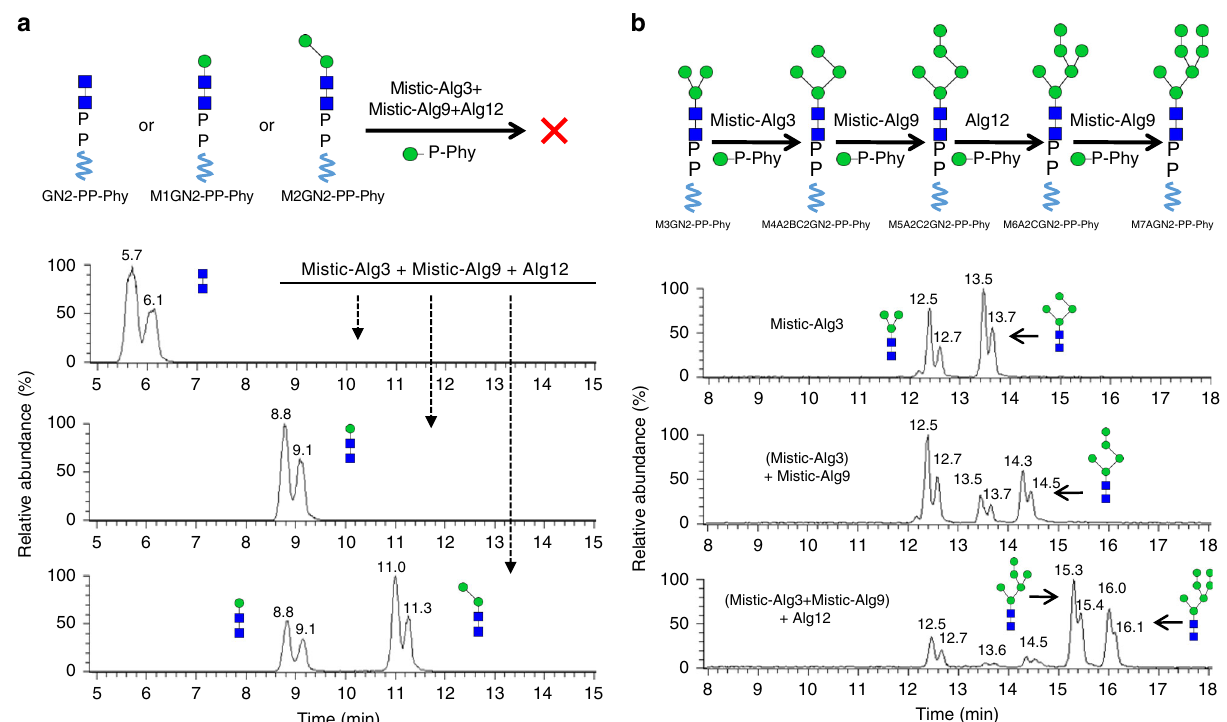
Fig. 6 Speci fi city of the ER luminal MTases for non-physiological substrates. a Reactions were performed in the presence of GN2-PP-Phy, M1GN2-PP-Phy, or a mixture of M1GN2-PP-Phy/M2GN2-PP-Phy, and Man-P-Phy. Products were analyzed by UPLC – MS. Addition of Mistic-Alg3, Mistic-Alg9, and Alg12 (Mistic-Alg3 + Mistic-Alg9 + Alg12) failed to elongate any of those substrates. b Reactions were performed in the presence of M3GN2-PP-Phy and Man-P- Phy. Stepwise addition of the membrane fractions of Mistic-Alg3, Mistic-Alg9, and Alg12 produced a variety of unusual LLOs, whose deduced structure is shown schematically. Addition of Mistic-Alg3 alone generated M4A2BC2GN2 (Mistic-Alg3); sequential addition of Mistic-Alg3 and Mistic-Alg9 generated M5A2C2GN2 [(Mistic-Alg3) + Mistic-Alg9]; sequential addition of Mistic-Alg3, Mistic-Alg9, and Alg12 generated M6A2CGN2 and M7AGN2 [(Mistic- Alg3 + Mistic-Alg9) + Alg12]. Products are indicated by the